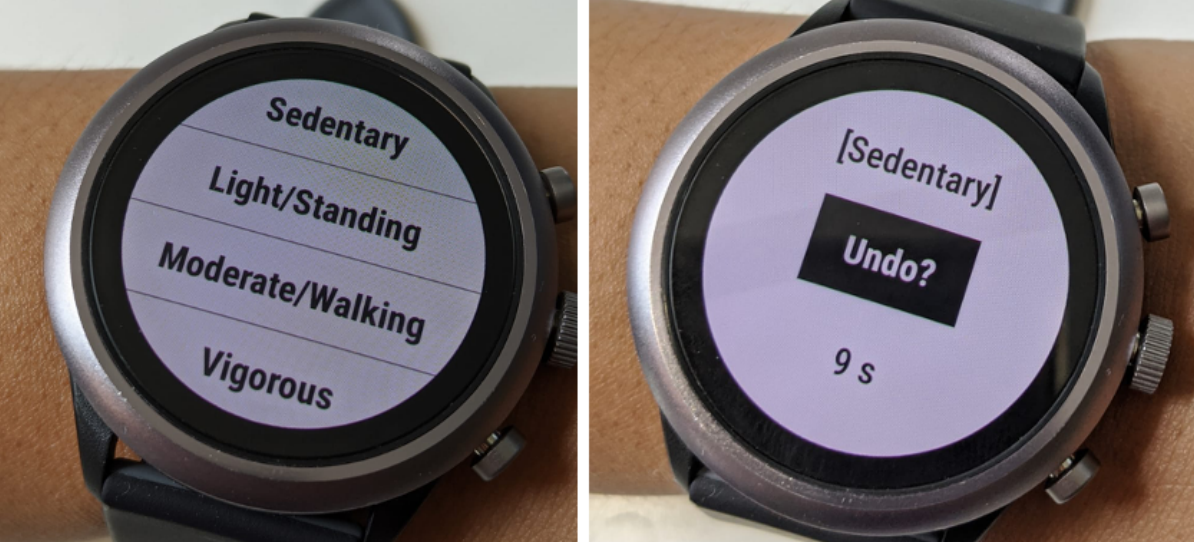
Figure 1. (Left) μEMA interface on a smartwatch with four activity intensity options. (Right) Undo screen to change response, available for 10 s, with a countdown